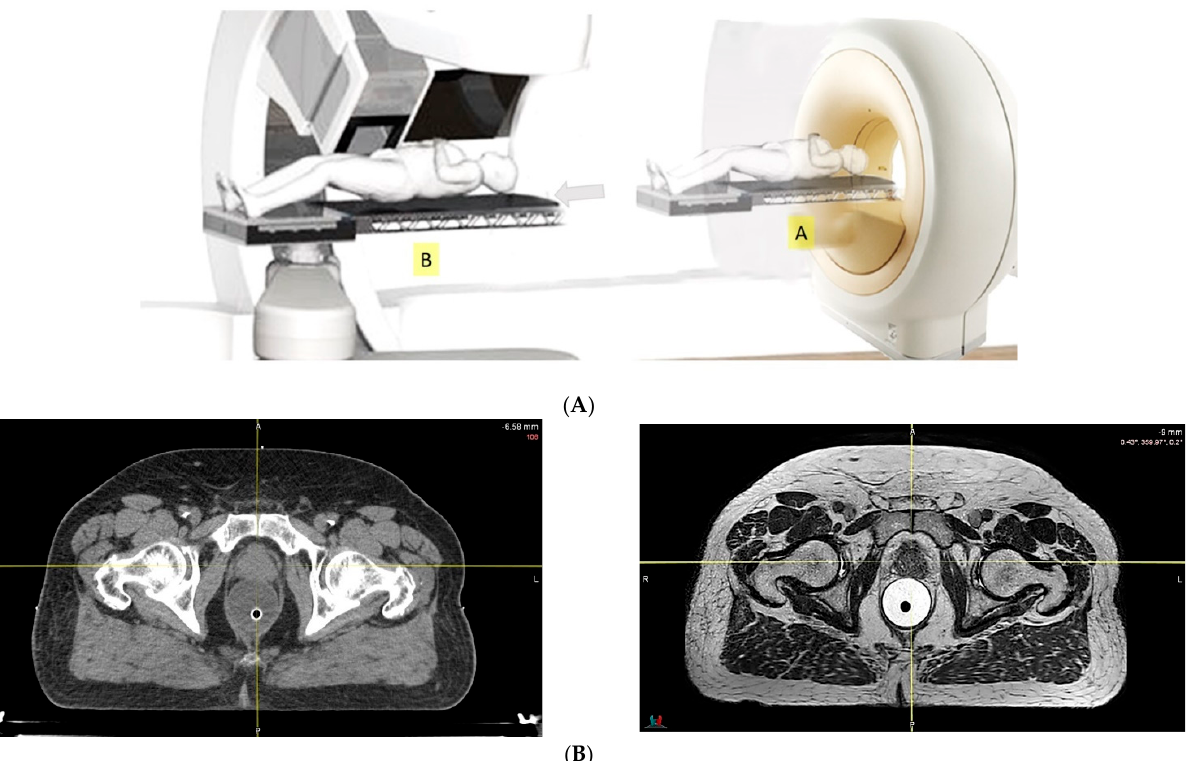
Figure 3. ( A ) Diagram of a proton therapy system with in-room magnetic resonance (MR). MR images are acquired first, with the patient lying on a robotic couch in position A, followed by relocation to position B for proton delivery, directly after image registration. ( B ) Comparison of computed tomography and MR images of prostate cancer.